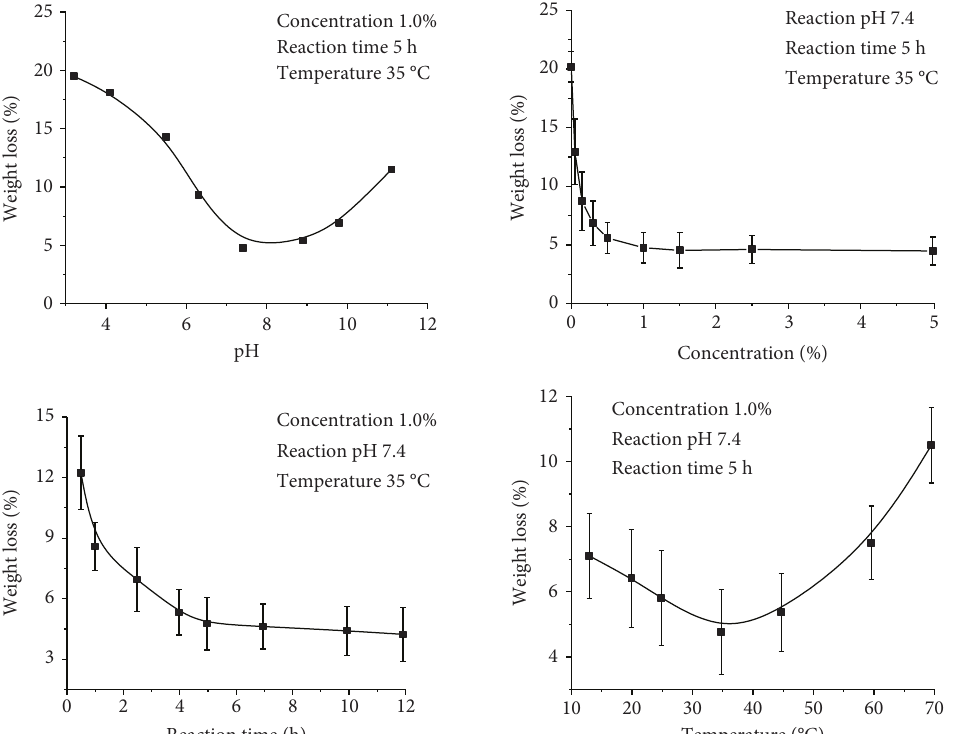
Figure 1: Weight loss of cross-linked fi ber during degumming as a function of the cross-linking pH, the concentration of phytic acid, reaction time, and temperature.